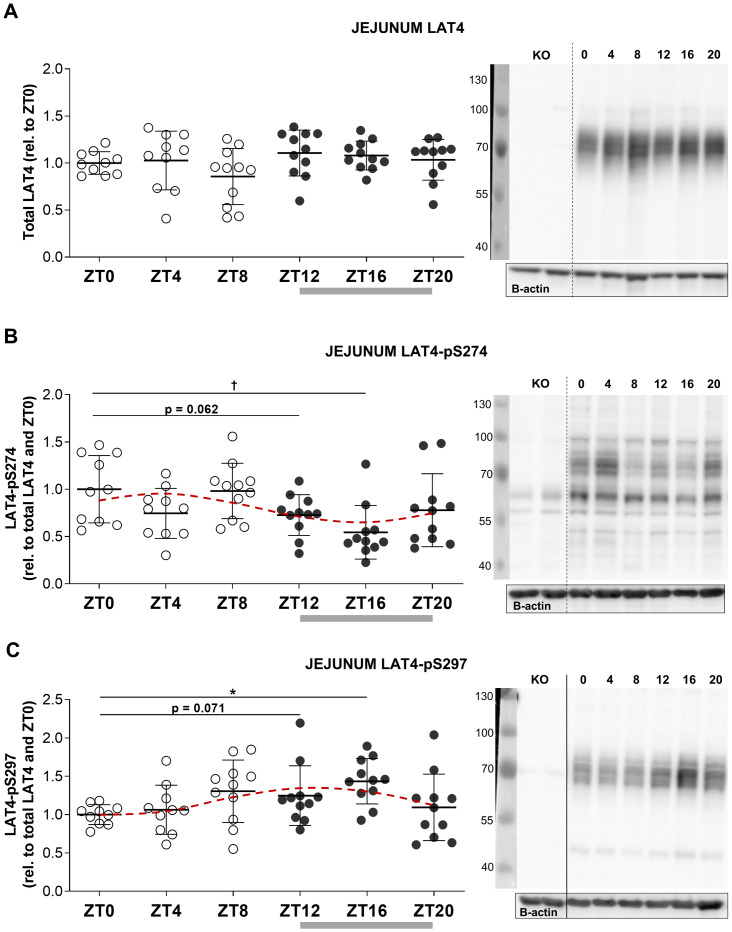
Only phosphorylation of LAT4 exhibits diurnal rhythmicity in jejunum of food-entrained wild type mice.Grey bar shows feeding period, red dotted line shows fitted cosine wave. A: LAT4 protein expression in jejunum. B: LAT4 phosphorylation on S274. C: LAT4 phosphorylation on S297. A to C: Total membrane lysates from jejunum of wild type (WT) and conditional LAT4 knockout (KO) mice analyzed by Western blot. Uninterrupted line between KO and other samples in the blot image indicates splicing—lanes from the same blot were rearranged to match the sample sequence of the blots shown in 3A and 3B. To quantify, all values were normalized to beta actin. Further normalization to LAT4 ratio was done for phospho-specific antibodies. Quantification is shown in the left panel, representative blots in the right panel. Statistical analysis was performed with One-way ANOVA using Tukey’s multiple comparison test, *p<0.05; †p<0.01. Mean (SD), n = 10–11 mice per time point from two separate experiments.